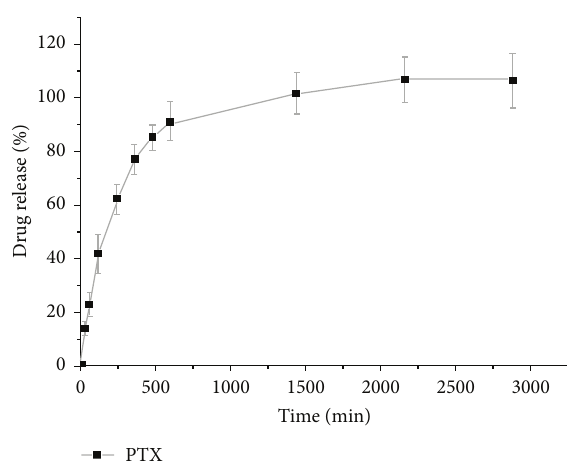
Figure5: Invitro releaseprofilesofPTXfromGA-PEG-GAmicelles in PBS at pH